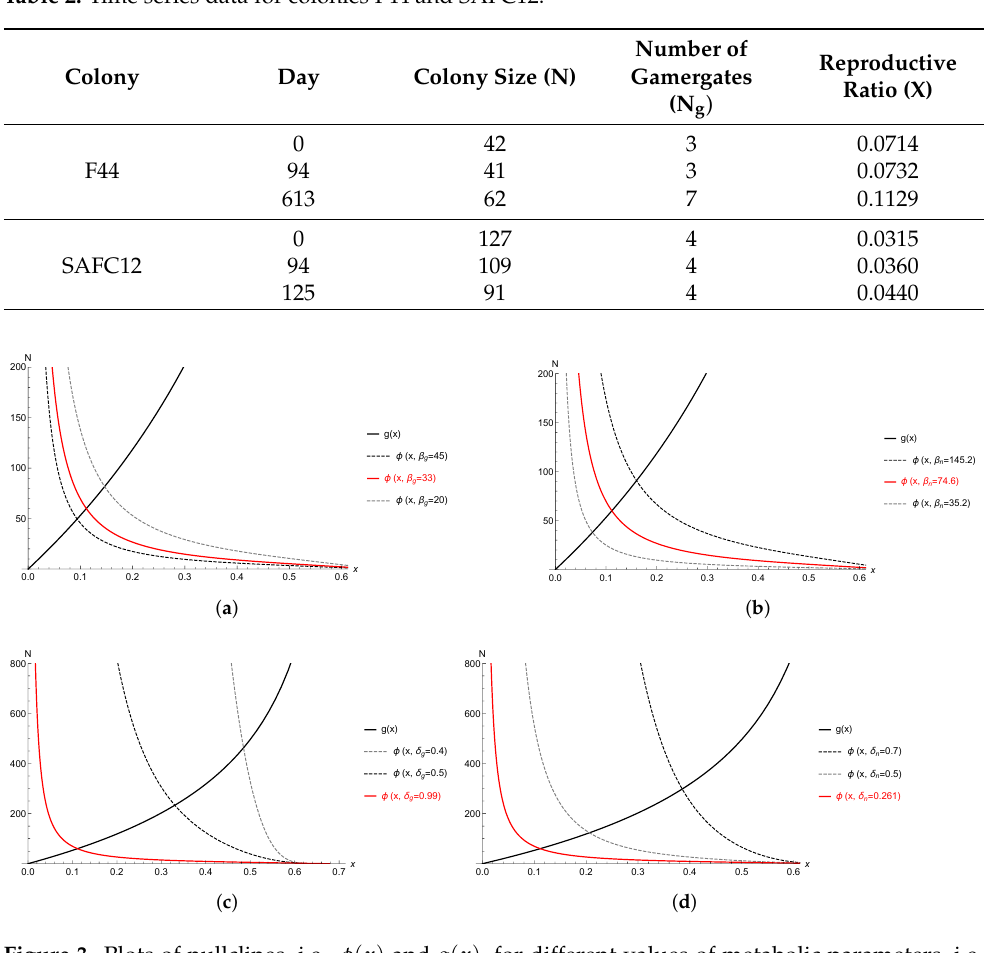
( b ) Colony SAFC12 best fits are β n = 121.15, δ g = 1.59 and δ n = 0.67